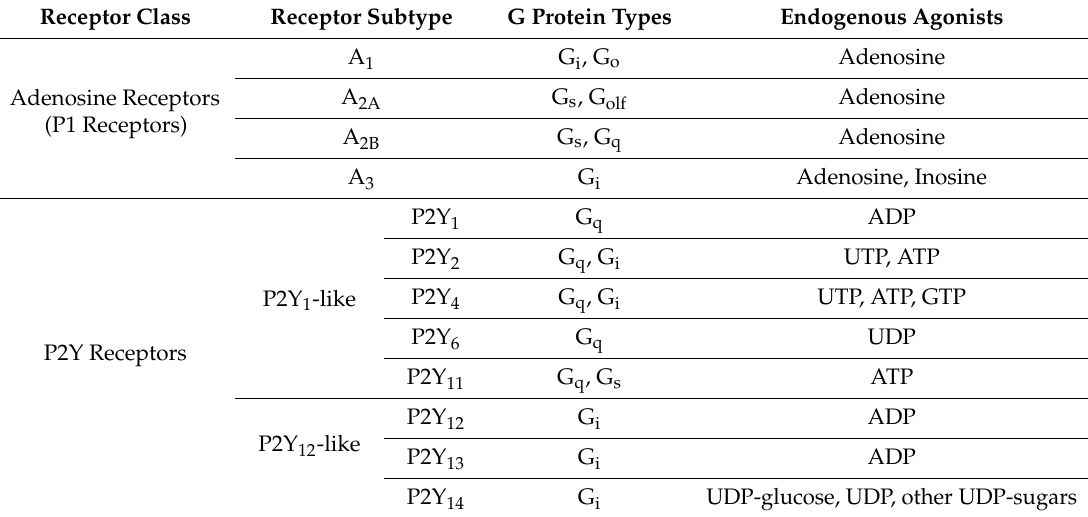
Table 1. Subtypes of adenosine receptors (ARs) and P2YRs and their